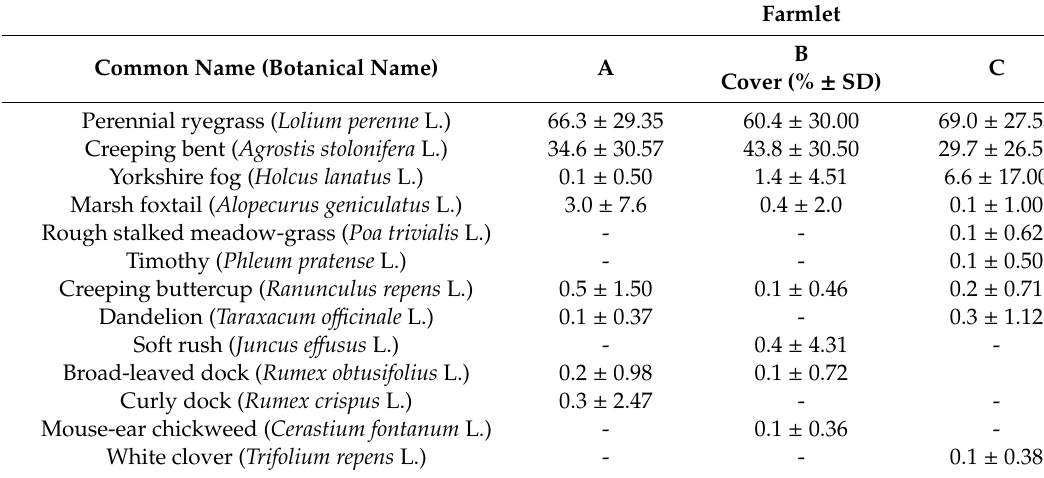
Table 2. Average percentage cover of plant species in July/August 2013, recorded as Domin using the classification of Rodwell [13].